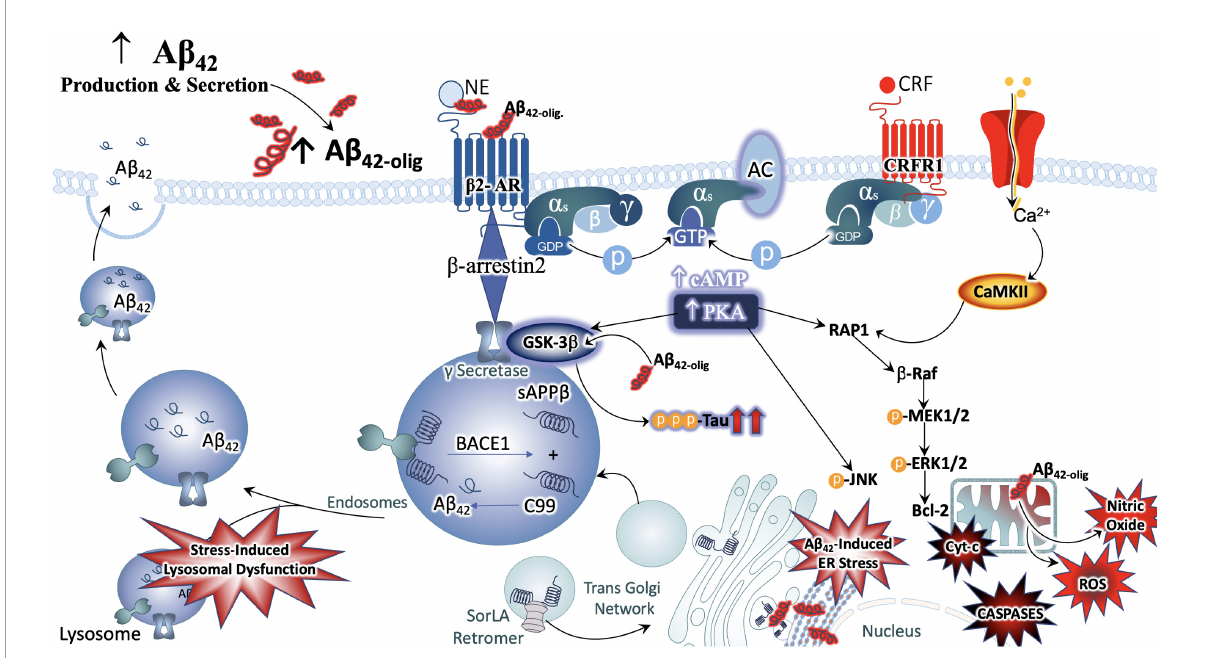
FIGURE3 Convergence of chronic stress intracellular signaling with A β 42 and hyperphosphorylated tau neuropathology. The noradrenergic and CRF systems are engaged during stress and may contribute to neuronal degeneration when sustained over long periods of time. Adrenergic and CRF receptors are known to shift APP processing toward the amyloidogenic pathway by influencing the activity of beta and gamma secretases, BACE1 and PSEN, respectively. Increased production and secretion of Ab42 results in increased production of the neurotoxic Ab42 oligomers, known to incite nitric oxide (NO), reactive oxygen species (ROS), lysosomal and endoplasmic reticulum (ER) stress. The beta-2 adrenergic receptor and CRF receptor 1 (CRFR1) are both G-protein coupled receptors that engage stimulatory alpha subunits. Activation of these receptors results in the activation of adenylyl cyclase (AC), increased production of cyclic adenosine monophosphate (c-AMP), and activation of the enzyme protein kinase A (PKA). PKA can activate GSK3b signaling, resulting in the phosphorylation of tau at Alzheimer’s relevant sites. PKA can also elicit intracellular calcium increases that result in the recruitment of the calcium modulatory kinase II (CaMKII). Sustained elevations in Ca2+ signaling, however, results in the activation of additional downstream cell signal cascades, exacerbating the production and release of NO, ROS, caspases, and cytochrome-c (Cyt-c) from mitochondria. Cumulatively, this results in decreased efficiency in clearing proteins from the cell, increased inflammation and signals that induce apoptosis, contributing to neuronal